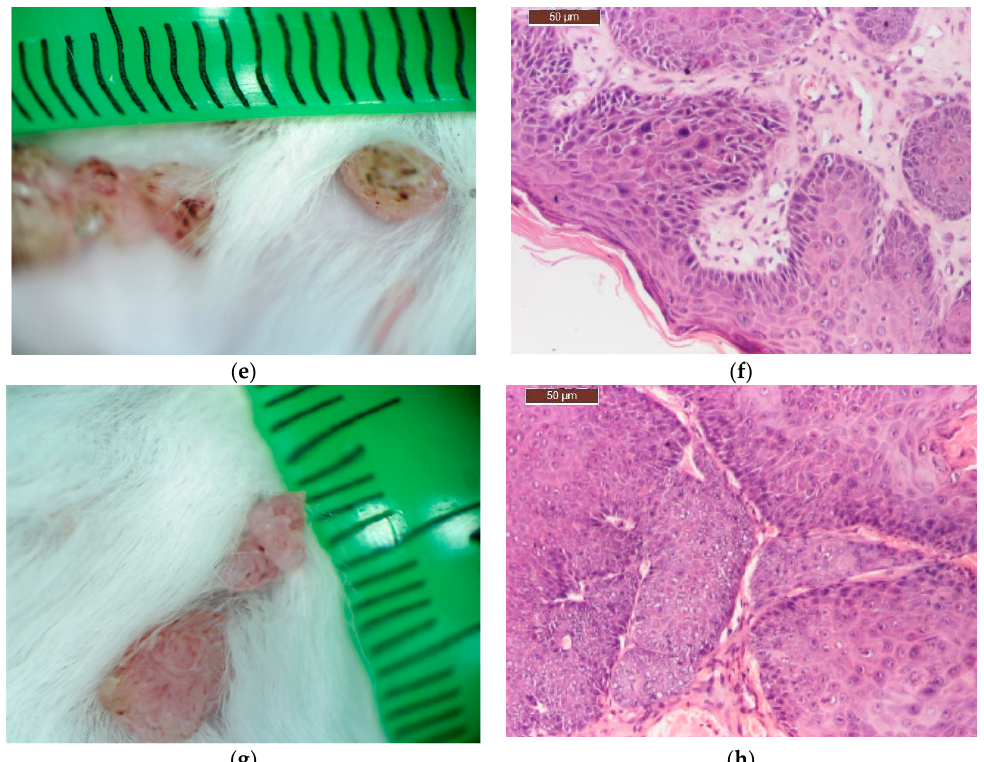
Figure 5. The tumour types chemically induced. The macroscopic tumour of origin and the H&E histological section pairs: ( a , b ) basal cell carcinoma (BCC); ( c – f ) squamous cell carcinoma (SCC); ( g , h ) basosquamous cell carcinoma (BSQCC).